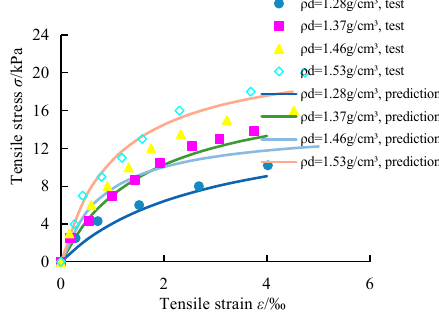
Figure 19. Measured and fitted tensile stress-strain curves ( ω = 22%).